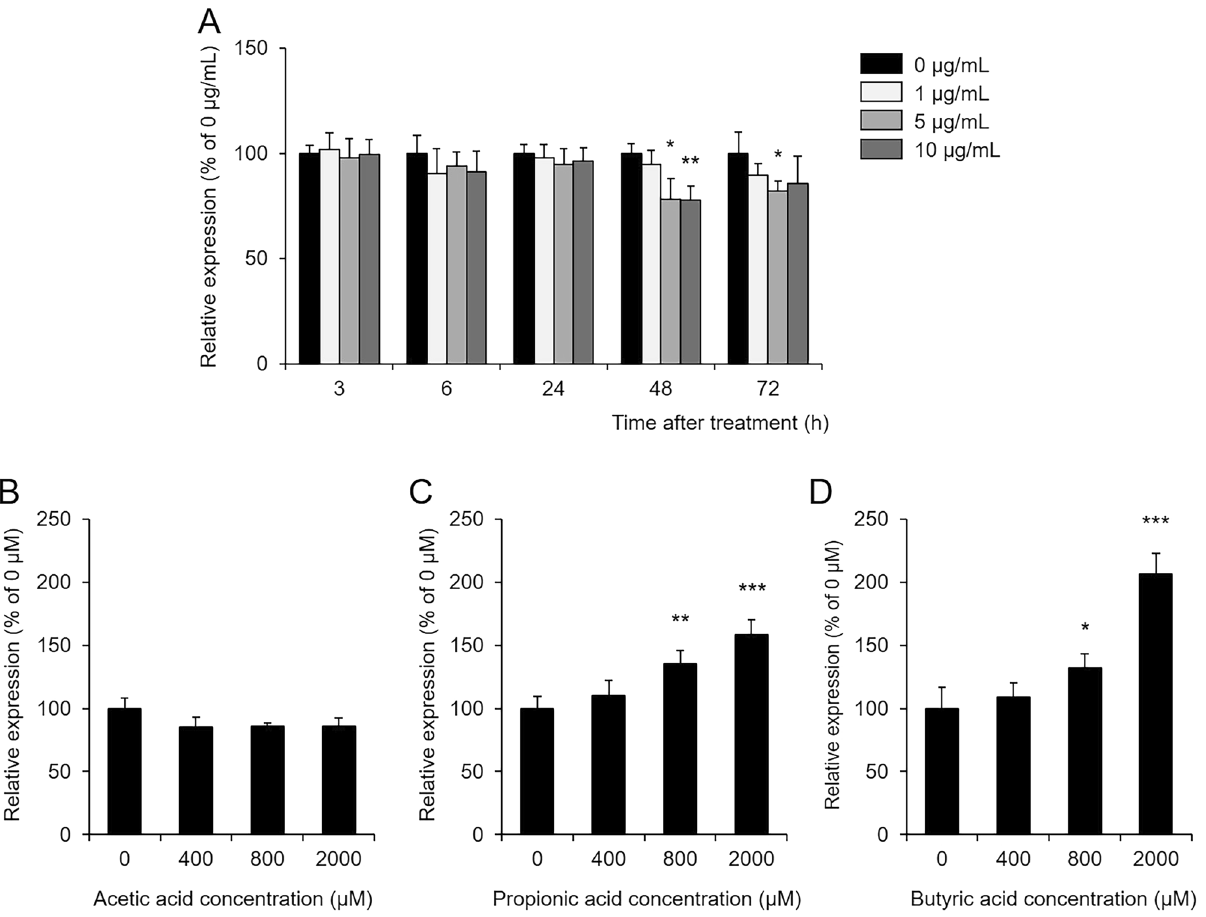
Figure 4. Effect of GTE and SCFAs on UGT1A1 expression in HT-29 cells. GTE ( A ), acetic acid ( B ), propionic acid ( C ), and butyric acid ( D ) were added to HT-29 cells, and the mRNA level of UGT1A1 was measured. UGT1A1 levels were normalized using GAPDH levels and are shown as 100% of the mean value in the control group (mean ± S.D., n = 4, * p < 0.05, ** p < 0.01, *** p < 0.001 vs. 0 μg/mL or 0